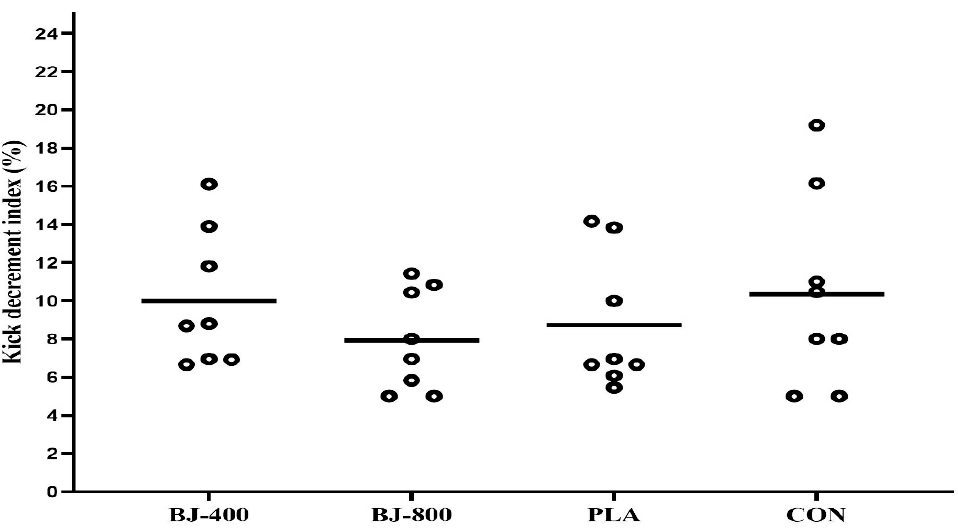
Figure 3. The kick decrement index in five sets of Frequency Speed of Kick Test in four treatments. BJ, beetroot juice; PLA, placebo; CON, control.